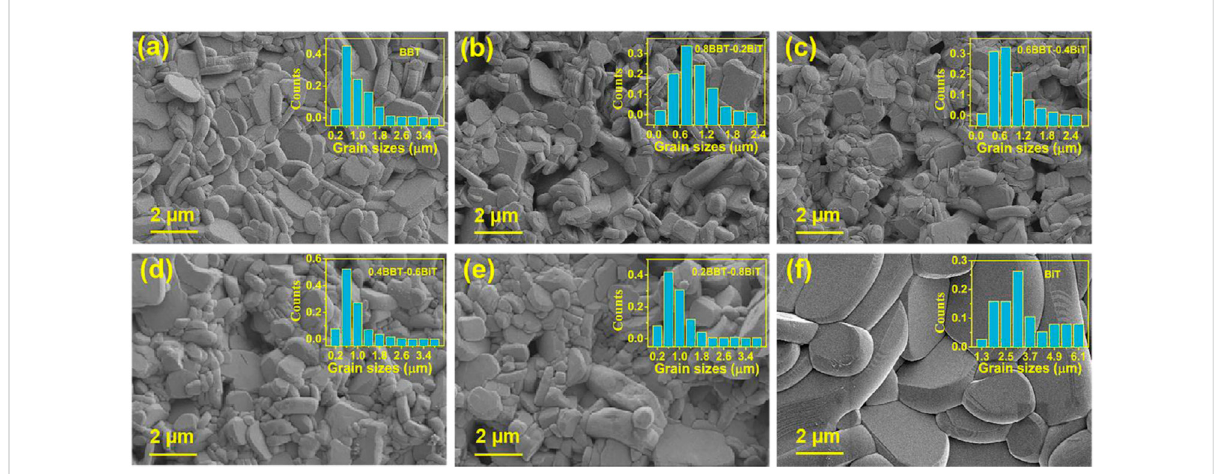
FIGURE 2 SEM images of (1- x ) BBT — x BiT ceramics at a sintering temperature of 1020 ° C: (A) BBT, (B) 0.8BBT-0.2BiT, (C) 0.6BBT-0.4BiT, (D) 0.4BBT- 0.6BiT, (E) 0.2BBT-0.8BiT, and (F) BiT.